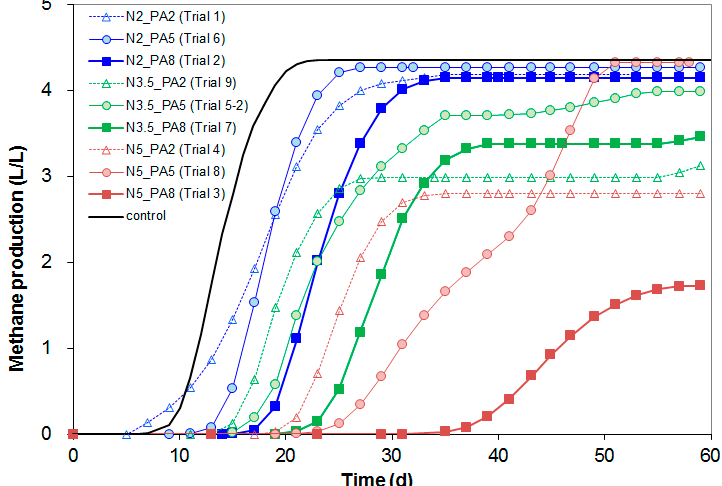
Figure 1. Profiles of methane production at di ff erent conditions. Blue, green and red colors represent initial TAN levels of 2.0 (N2), 3.5 (N3.5) and 5.0 (N5) g / L, respectively. Triangles (empty), circles (pale filled) and squares (filled) represent initial propionate levels of 2.0 (PA2), 5.0 (PA5) and 8.0 (PA8) g / L,